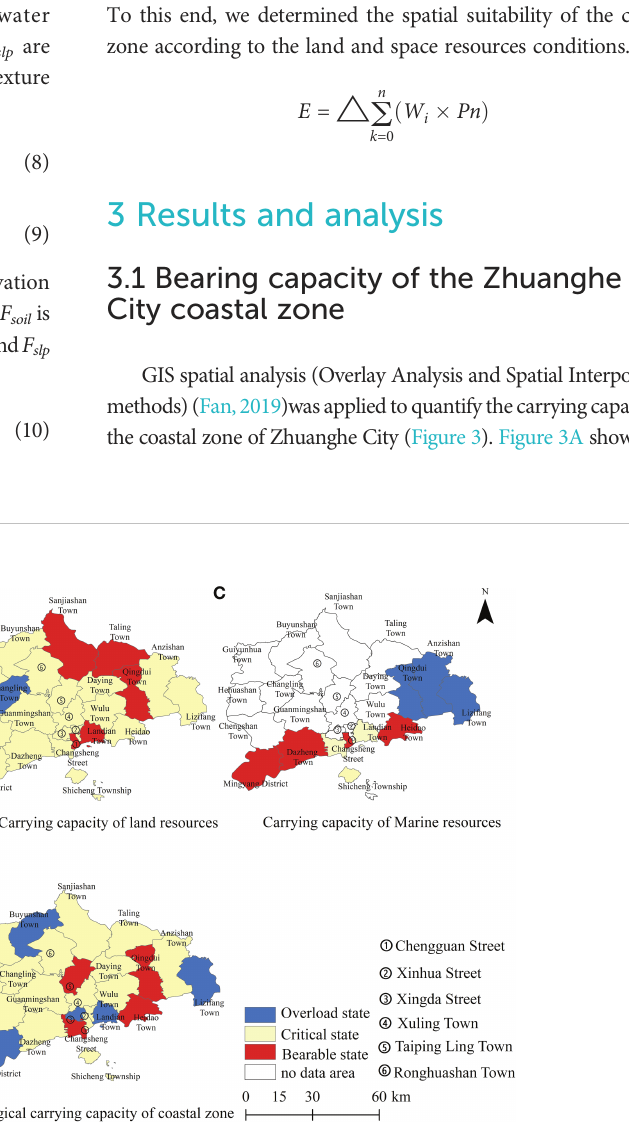
FIGURE 3 Evaluation of resource and environmental carrying capacity of the coastal